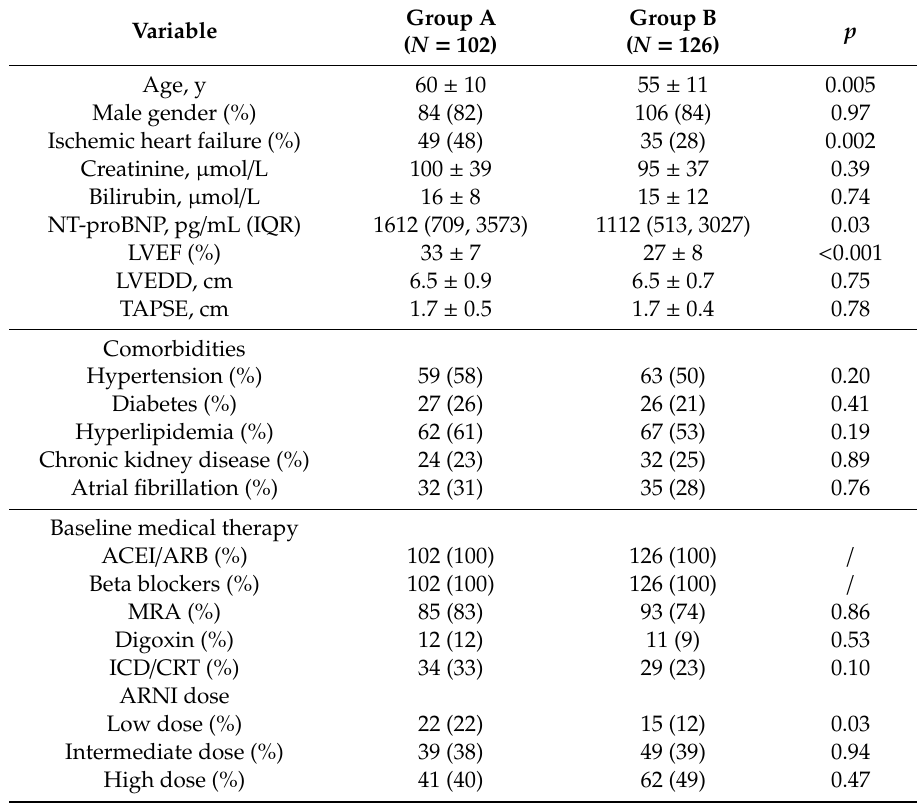
Table 2. Baseline characteristics of patients according to the response to ARNI therapy.